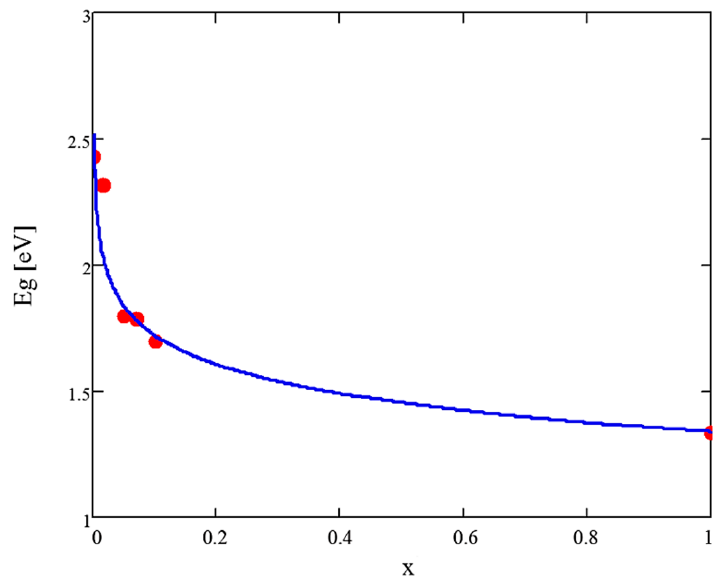
Figure 6. Energy gap values E g vs. the composition x of the CdS 1 − x Te x samples. Full circles are experimental results. The solid line is the approximation curve.